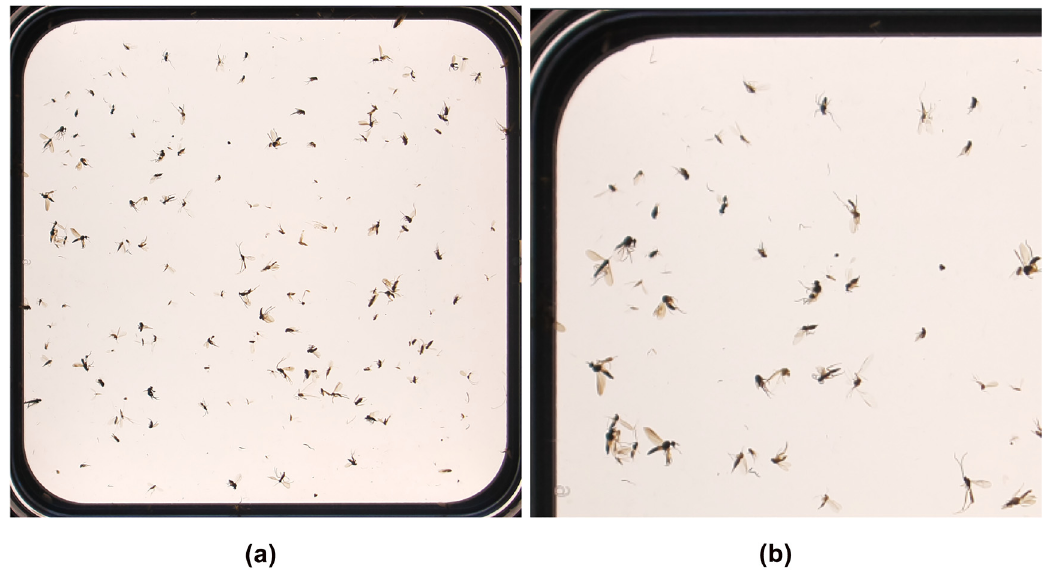
Figure 12: Illustration of image cropping. A crop (b) of an original image (a) is generated [5]. Using this example, it becomes clear that generating crops can simplify annotation in the case of many instances given within a sample. (a) Original Image. (b) Cropped Image.